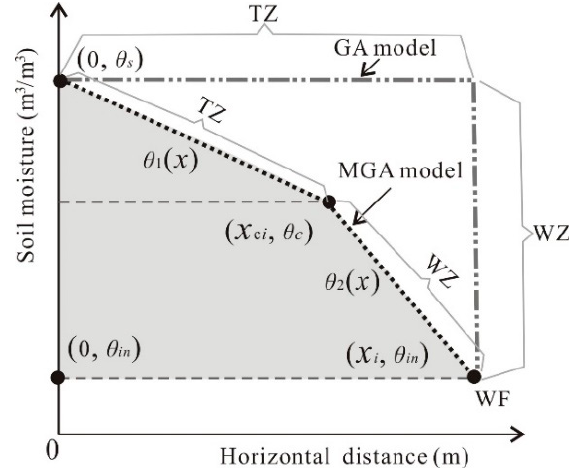
Figure 1. Assumed soil moisture profiles in the Green–Ampt (GA) and modified Green–Ampt (MGA) models. θ S is saturated soil moisture (m 3 /m 3 ), θ c is critical soil moisture between transmission zone (TZ) and wetting zone (WZ) (m 3 /m 3 ), θ in is initial soil moisture (m 3 /m 3 ), θ 1 ( x ) is soil moisture profile function in the transmission zone (m 3 /m 3 ), θ 2 ( x ) soil moisture profile function connected with TZ in the wetting zone (m 3 /m 3 ), x ci is advancement distance of the intersection point of two linear functions in the wetting zone and in the transmission zone (m), x i is advancement distance of the WF (m), TZ is transmission zone, WZ is wetting zone, WF is wetting front, and i means a moment during the infiltration process.